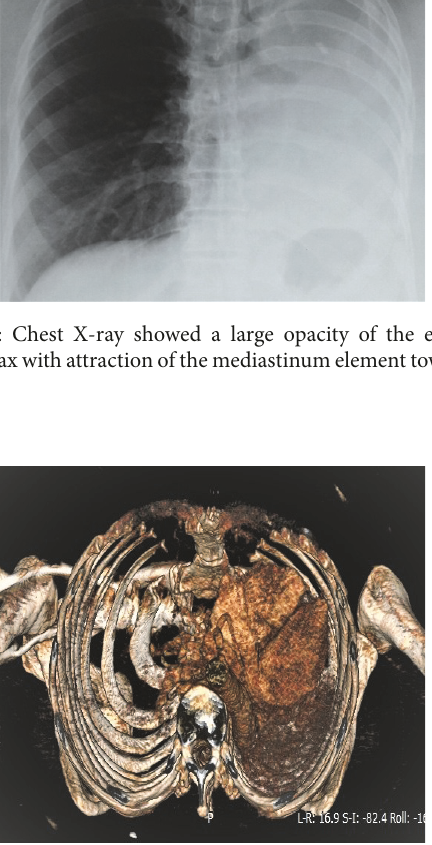
Figure 2: 3D CT scan in axial tomography of the chest confirmed a total left lung